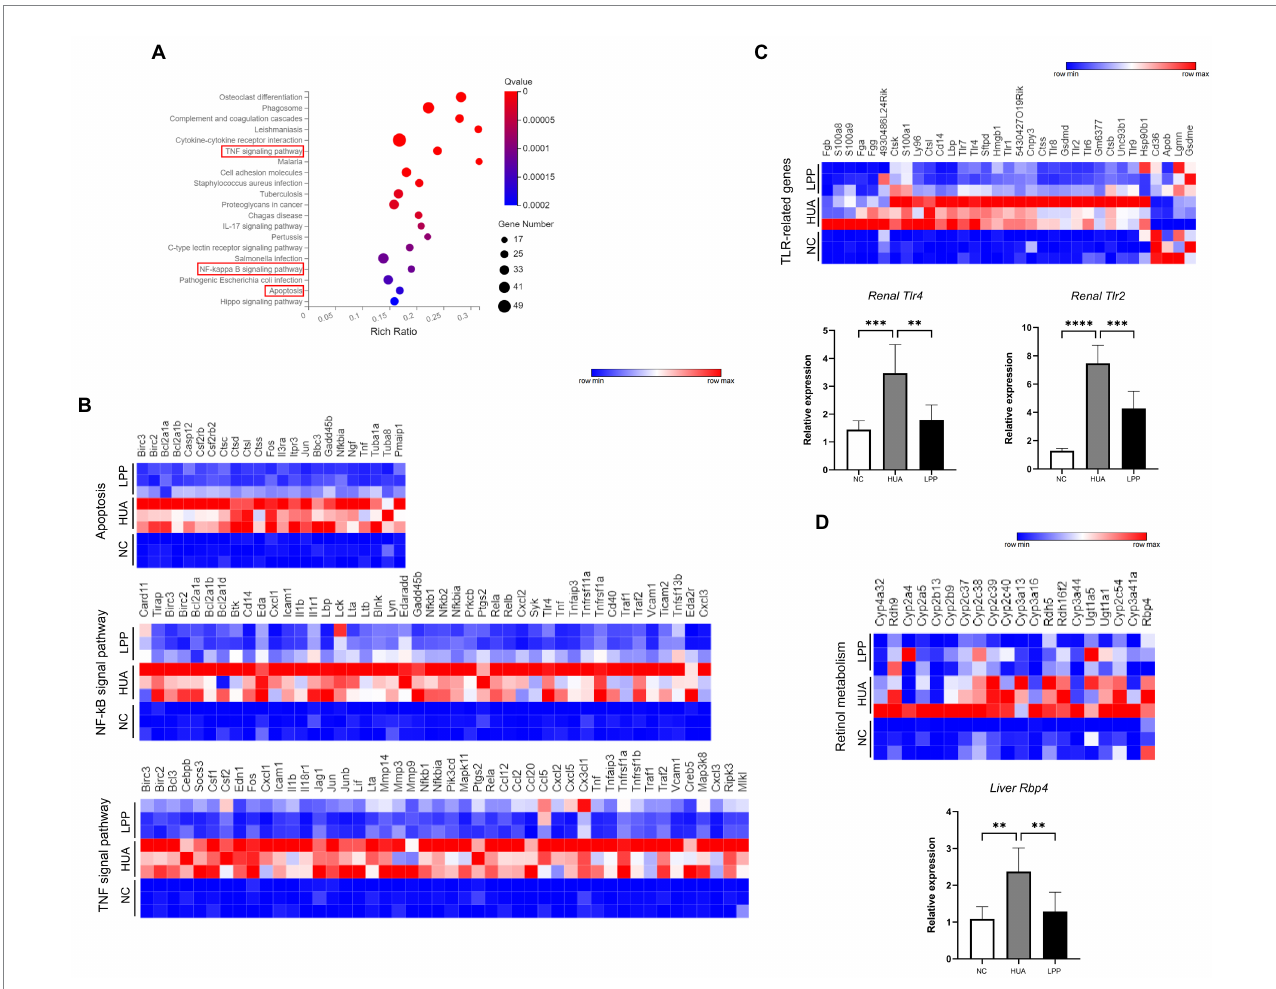
FIGURE 6 Transcriptome data revealed the potential mechanisms for UA-induced renal inflammation and LPP protective effect. (A) Bubble diagram of the top 20 KEGG pathways downregulated in the LPP group compared with the HUA group in renal tissue. (B) Heatmap depiction of the expression of apoptosis, TNF, and NF-kB signal pathway in renal tissue from different groups. (C) Heatmap depiction of the expression of TLR-related genes and qPCR results of Tlr2/4 in renal tissue from different groups. (D) Heatmap depiction of retinol metabolism signal pathway and qPCR results of Rbp4 in liver tissue from different groups. Bars are means ± SD, p < 0.05 was set as the threshold for significance by one-way ANOVA followed by post hoc comparisons using Tukey’s test for multiple groups’ comparisons, * p < 0.05; ** p < 0.01; *** p < 0.001; **** p <